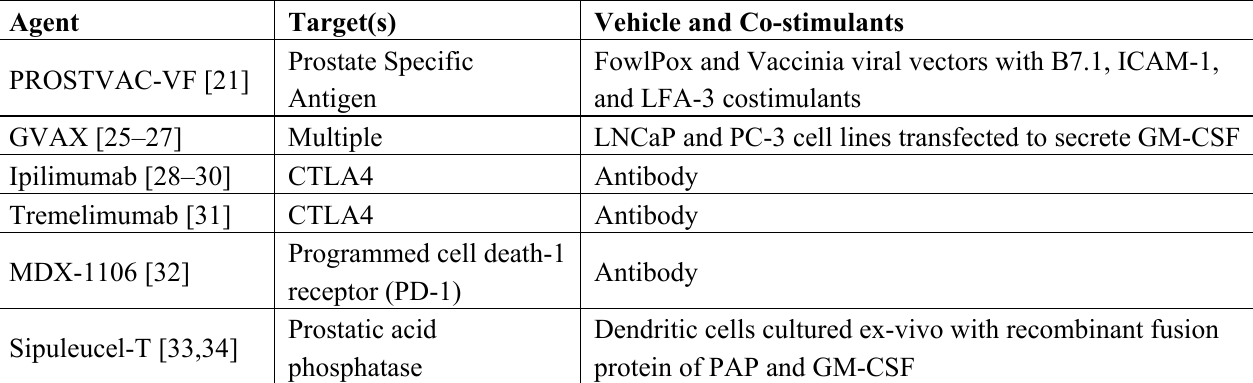
Table 1. Immune agents for prostate cancer discussed in this review, with their target(s) and